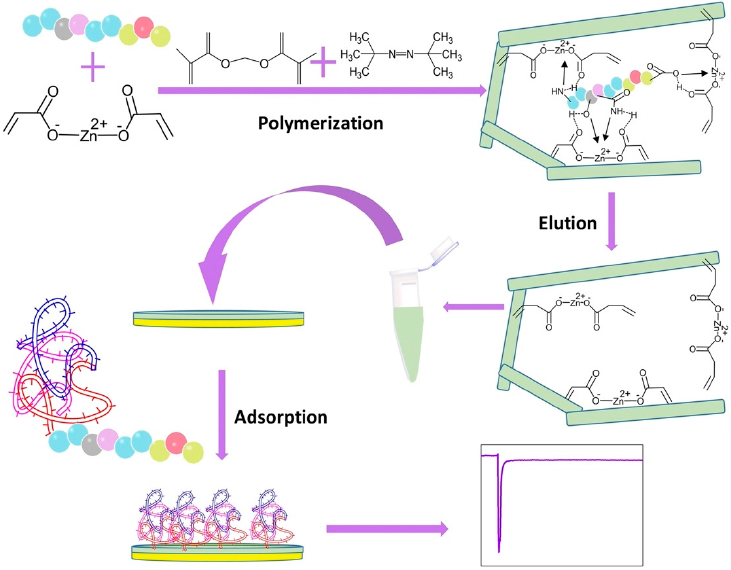
Figure 6. The preparation process of epitope-imprinted-QCM sensor. Reprinted from [79] with permission from Ma et al.